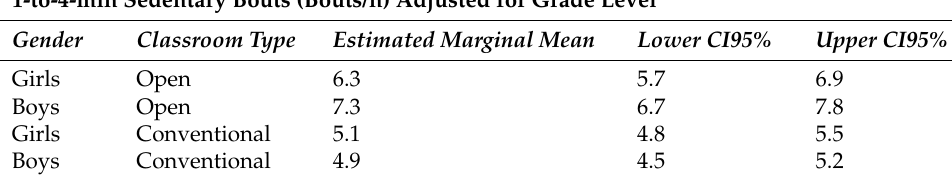
Table 3. Estimated marginal means of post hoc analyses after three-way